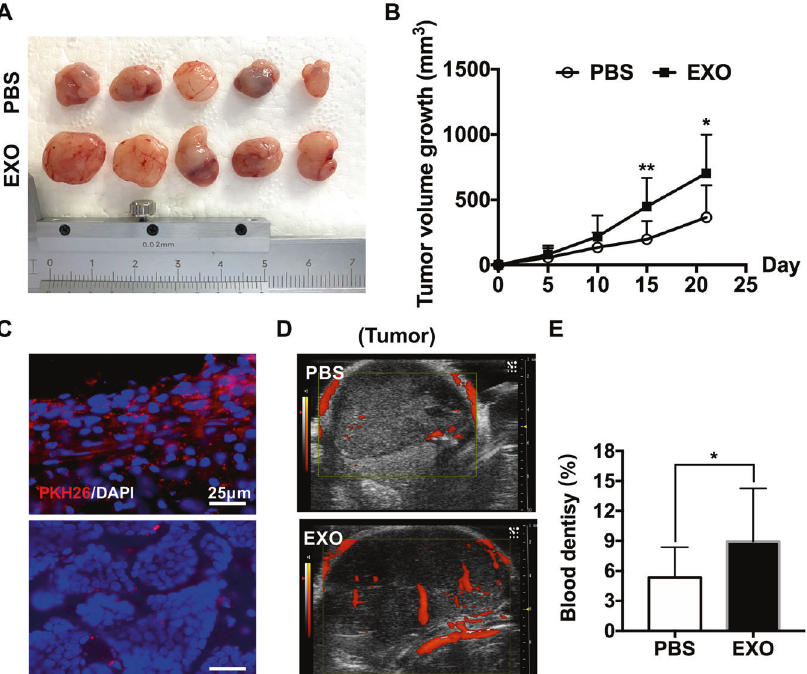
Fig. 3 Exosomes derived from WERI-Rb1 cells were engulfed by tumor cells and promoted the growth of retinoblastoma. A Representative macroscopic appearance of tumors after subcutaneously injection PBS or exosomes for 21 days. B The tumor volume growth curve in the xenotransplantation model ( n = 14, * P < 0.05, ** P < 0.01). C PKH26-labeled exosomes (red) were internalized by cells from tumor tissues after 10 days after exosomes injection. DAPI was used to stain the nuclei. Bar = 25 μ m. D Ultrasound analysis showed that blood fl